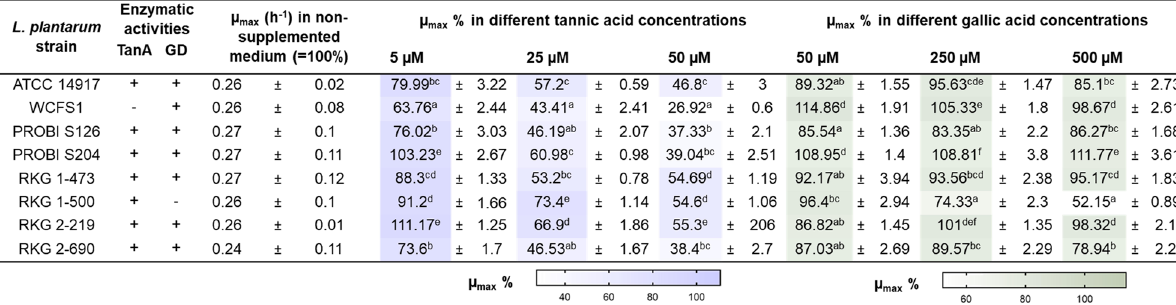
Table 1. Growth response of L. plantarum’ to the presence of tannic and gallic acid phenolics in a minimal growth medium. Data in the same column with different letters are significantly different at < p 0.01. Statistical significance was determined by a two-way ANOVA ( p < 0.05) followed by Tukey’s multiple comparisons test. Color intensity increases proportionally to the mean values. Heat map colors were obtained in